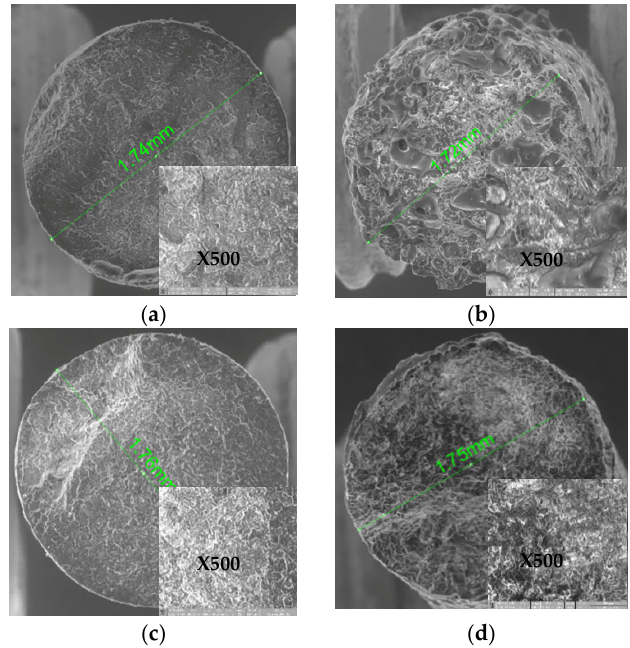
Figure 1. The SEM wires images: ( a ) Arboblend V2 Nature, ( b ) Arbofill Fichte, ( c ) Arboblend V2 Nature reinforced with Extrudr BDP “Pearl”, ( d ) Fiber Wood.